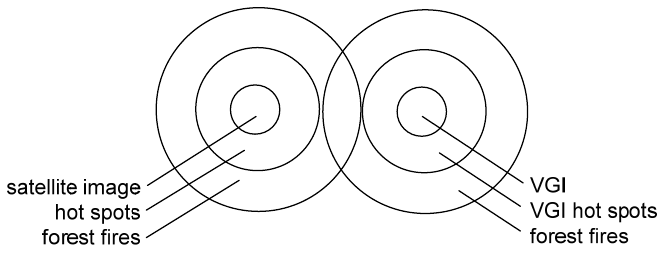
Figure 3. Detecting forest fires using satellite images and